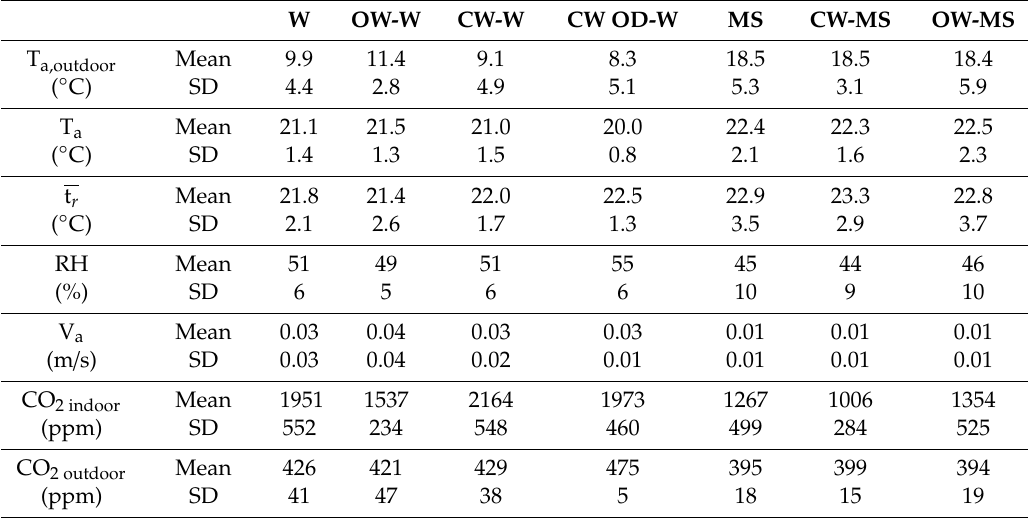
Table 5. Mean values of environmental parameters obtained during the field measurements related to seasons and windows’ and doors’ operation. W OW-W CW-W CW OD-W MS